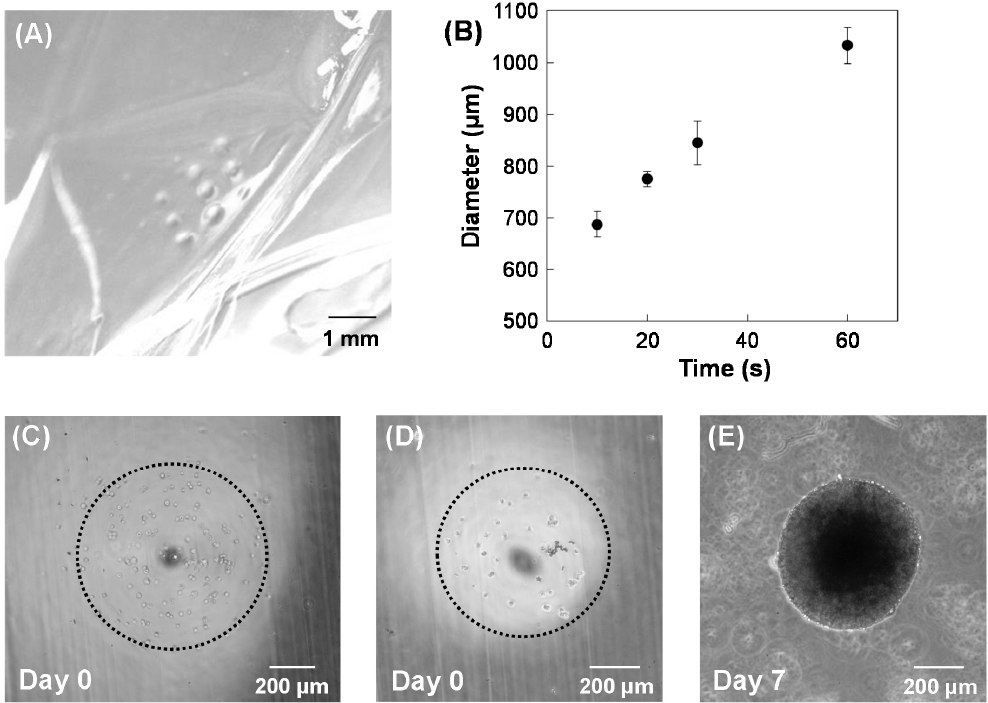
Figure 4. Fabrication of calcium-alginate/collagen hydrogels. ( A ) Image of a 3 × 3 dot array of the hydrogel; ( B ) Dependence of dot diameter of the hydrogels on voltage application time. HepG2 cells were embedded within the hydrogels ( C ); or seeded on the hydrogels and cultured for zero ( D ) and seven days ( E ).